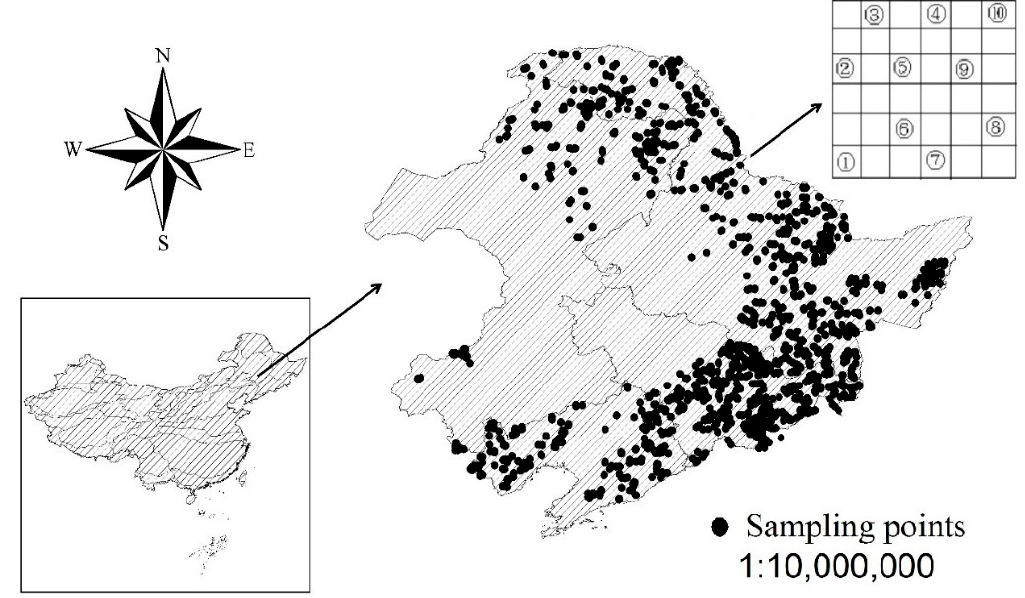
Figure 1. Sampling points in the study area.